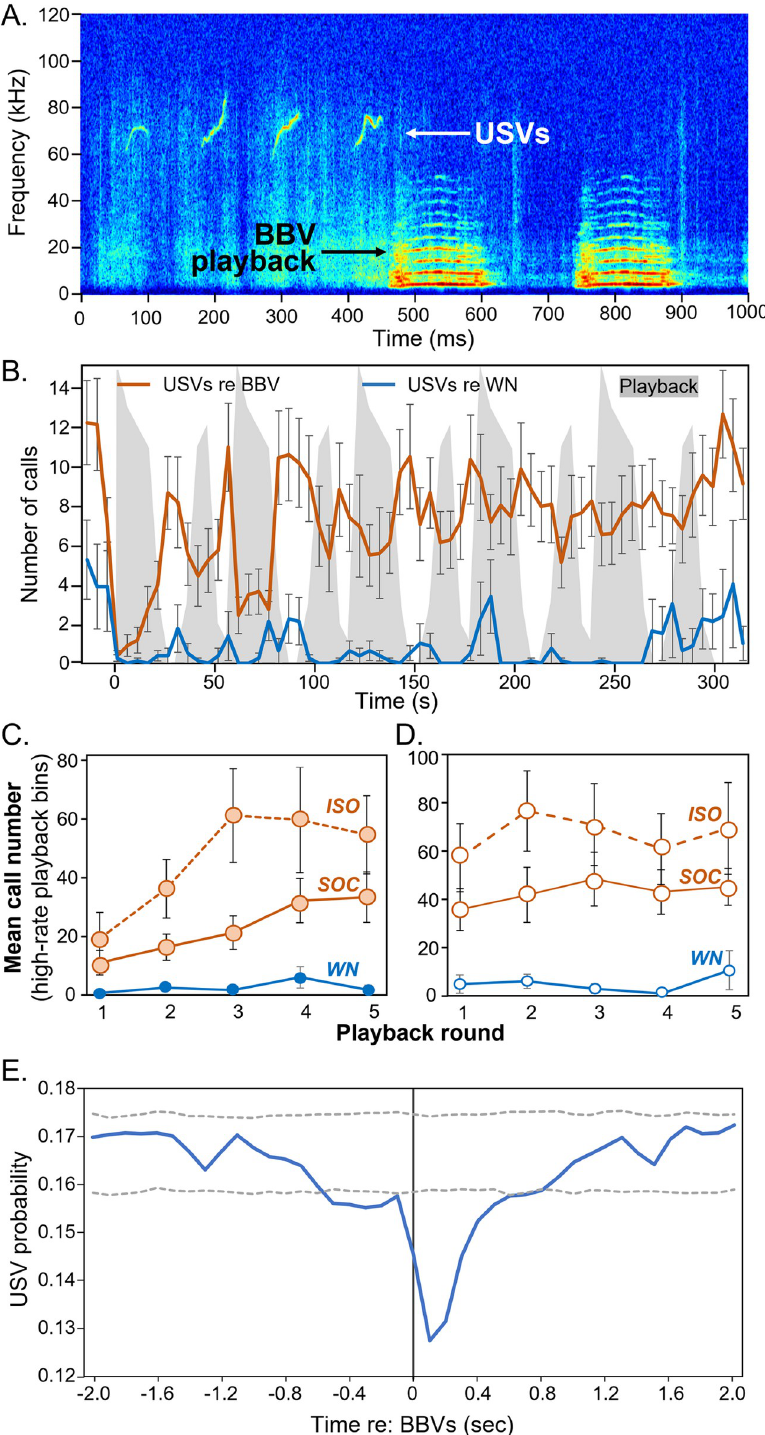
Fig 6. Interaction of BBV playback with USV production during the playback period. A) Clip of one experiment showing cessation of USVs at the onset of BBV playback. B) Interleaving of BBVs and USVs during the 5 minutes (300 s) of playback, in 5s bins. Three time bins before and after the onset of playback are also represented. Gray shade represents numbers of played stimuli in 5s bins of the playback. Bins contained either 3 or fewer, or 11 or more, BBVs. Orange line shows average USVs in each 5s bin for experiments using Exemplar A (n = 19). Blue line represents USV